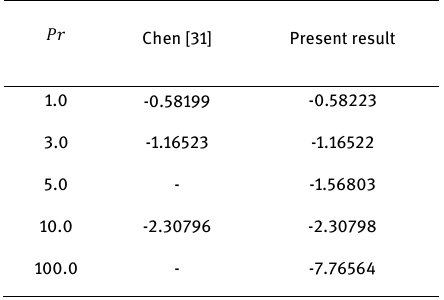
(︁ )︁ 1 + Rθ 3 θ ′ (0) for various physical parameter. w